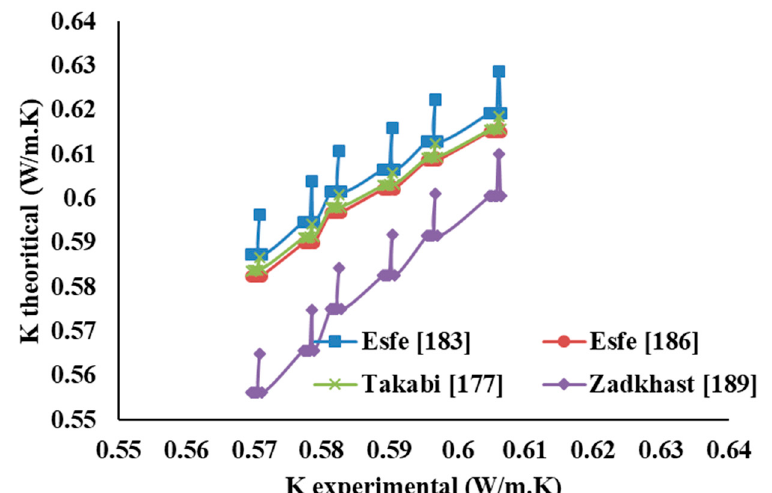
Figure 6. Comparison of experimental and empirical results for thermal conductivity.